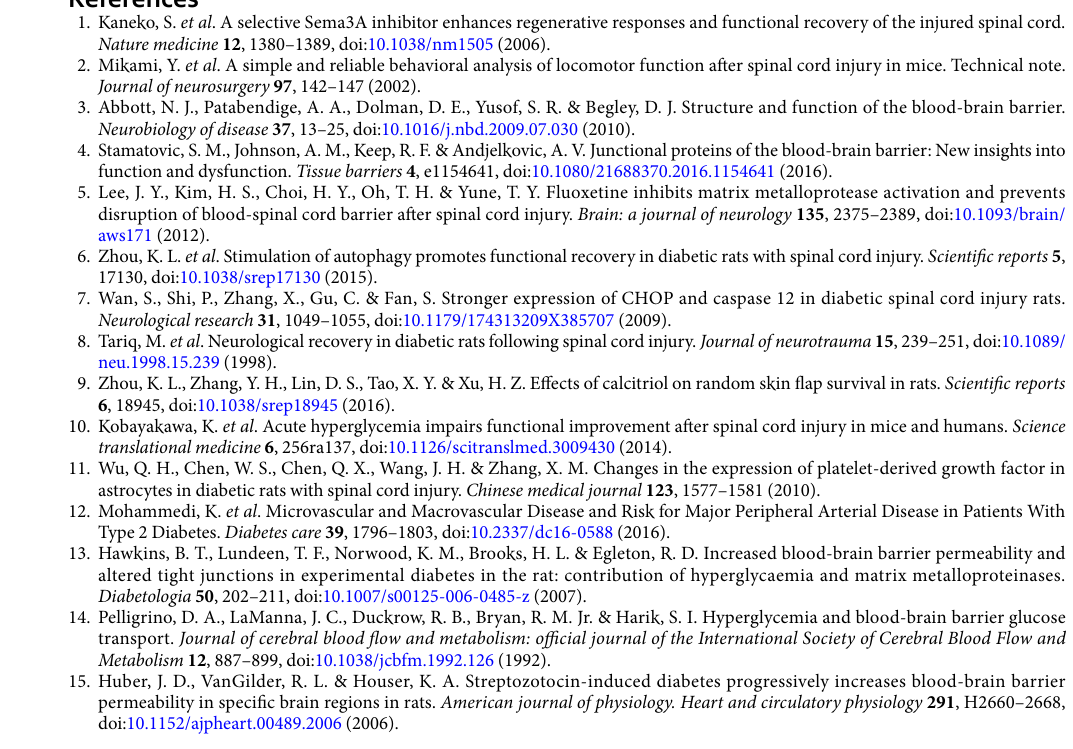
ant-PDGFR- β (1:400, Abcam), rabbit ant-p120 (1:400, Abcam), rabbit ant-claudin-5 (1:100, Santa Cruz, CA, USA), rabbit ant-GRP78 (1:400, Abcam) and rabbit ant-CHOP (1:100, Santa Cruz) as primary antibody in 4 °C overnight. The sham control group was operated by using PBS, but not primary antibody. After triple washing in PBS at room temperature, the sections were once again incubated with goat anti-rabbit Alexa Fluor 488 (1:1000, Abcam) and donkey anti-mouse TR (1:1000, Abcam) as secondary antibody for 1 h. For cell immunostaining, the HBMEC sub- jected to the indicated treatments, were plated on slips. After triple washing in PBS, the slips were fixed in 4% para- formaldehyde for 0.5 h, and blocked with 5% BSA in 37 °C oven for 0.5 h. Then, the slips were incubated with rabbit ant- β -catenin (1:400, Abcam) as primary antibody in 4 °C overnight, following by incubation with goat anti-rabbit Alexa Fluor 488 (1:1000, Abcam) as secondary antibody for 1 h. The nuclei were stained with DAPI for 5 min at room temperature. Images was observed by a confocal microscopy. A negative (no antibody) control was included. Western blot analysis. 24 rats were euthanized with pentobarbital sodium overdose, and transcardially per- fused with 0.9% NaCl 1d after injury. Total proteins from the spinal cord tissues near the lesion (0.5 cm length) and HBMEC were purified using protein extraction reagents. The equivalent of 70 μ g of protein was separated on 11.5% gel and transferred onto a PVDF membrane (Bio-Rad Laboratories). The membranes were blocked with 5% skim milk-TBST for 1.5 h at room temperature. Then, the membranes were incubated with primary antibodies as follows: rabbit ant-PDGFR- β (1:1000, Abcam), rabbit ant-p120 (1:1000, Abcam), rabbit ant- β -caternin (1:1000, Abcam), rabbit ant-Occludin (1:1000, Cell Signal Technology), rabbit ant-claudin-5 (1:300; Santa Cruz), mouse ant-ATF-6 (1:1000, Abcam), rabbit ant-PDI (1:1000, Abcam), rabbit ant-GRP78 (1:1000, Abcam), rabbit ant-CHOP (1:300; Santa Cruz), and rabbit ant-caspase 12 (1:1000, Abcam) as primary antibody in 4 °C overnight. After triple wash- ing in TBST, the membranes were incubated with goat anti-rabbit or goat ant-mouse secondary antibody for 1 h. Enhanced chemiluminescence (ECL) kit was used to detect the targeted bands in the membranes. Band intensity was quantified using Image Lab 3.0 software (Bio-Rad Laboratories). Experiments were repeated three times. Cell culture.